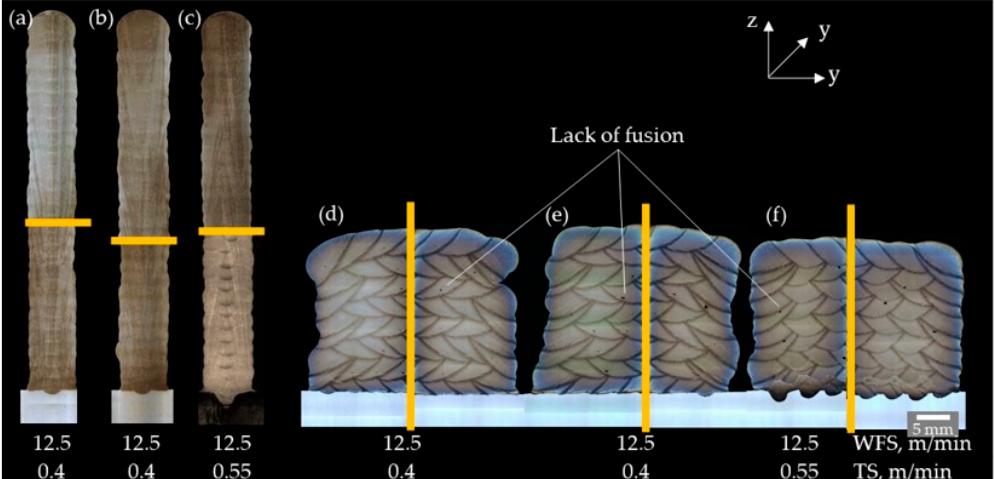
Figure 11. Macro sections (Y–Z plane) of walls ( left ) and blocks ( right ) with HY282 ( Φ 0.035 ″ ) de- pending on shielding gases. ( a , d ) ArHeHC; ( b , e ) ArHeH; ( c , f ) ArHeNC (wall: etched with Beraha III, block: electrolytic etched with 10% CrO 3 and 90%